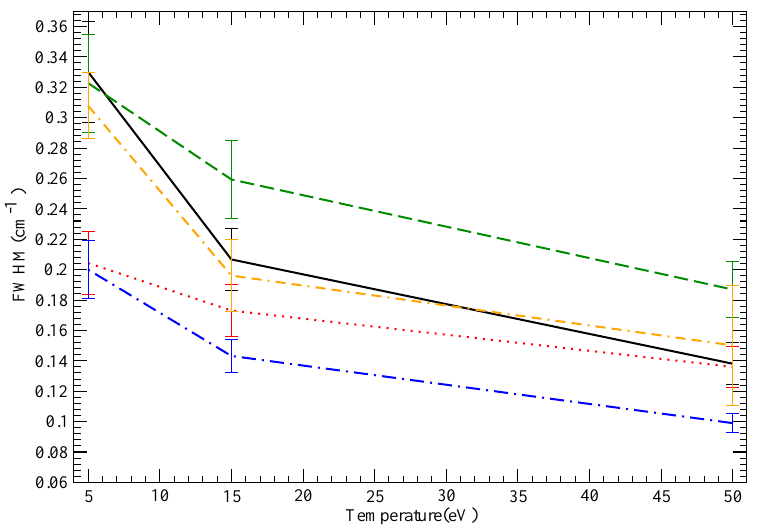
Figure 2. A comparison of hyperbolic trajectory B III 2s-2p transition widths as computed by SCP (solid black), SimU (dotted red), DARC (dashed green) and Starcode with (dash-dotted blue) and without (dot-double dash orange) penetration accounted